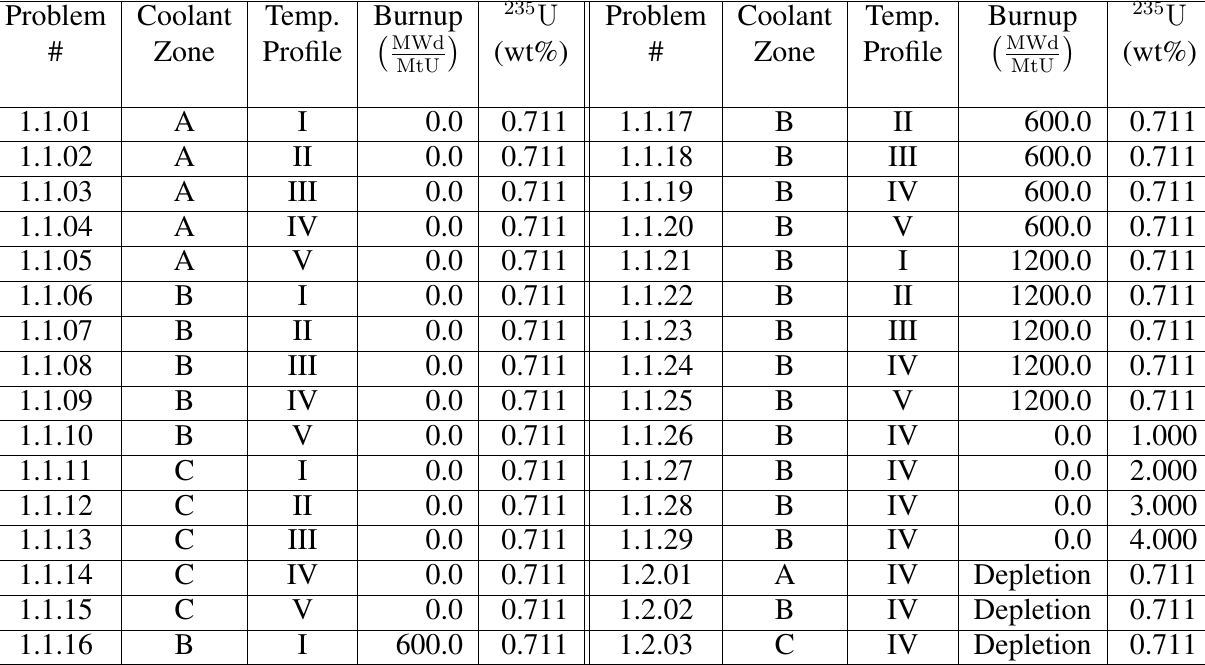
Table 2: Single State Point Pin-Cell Problem